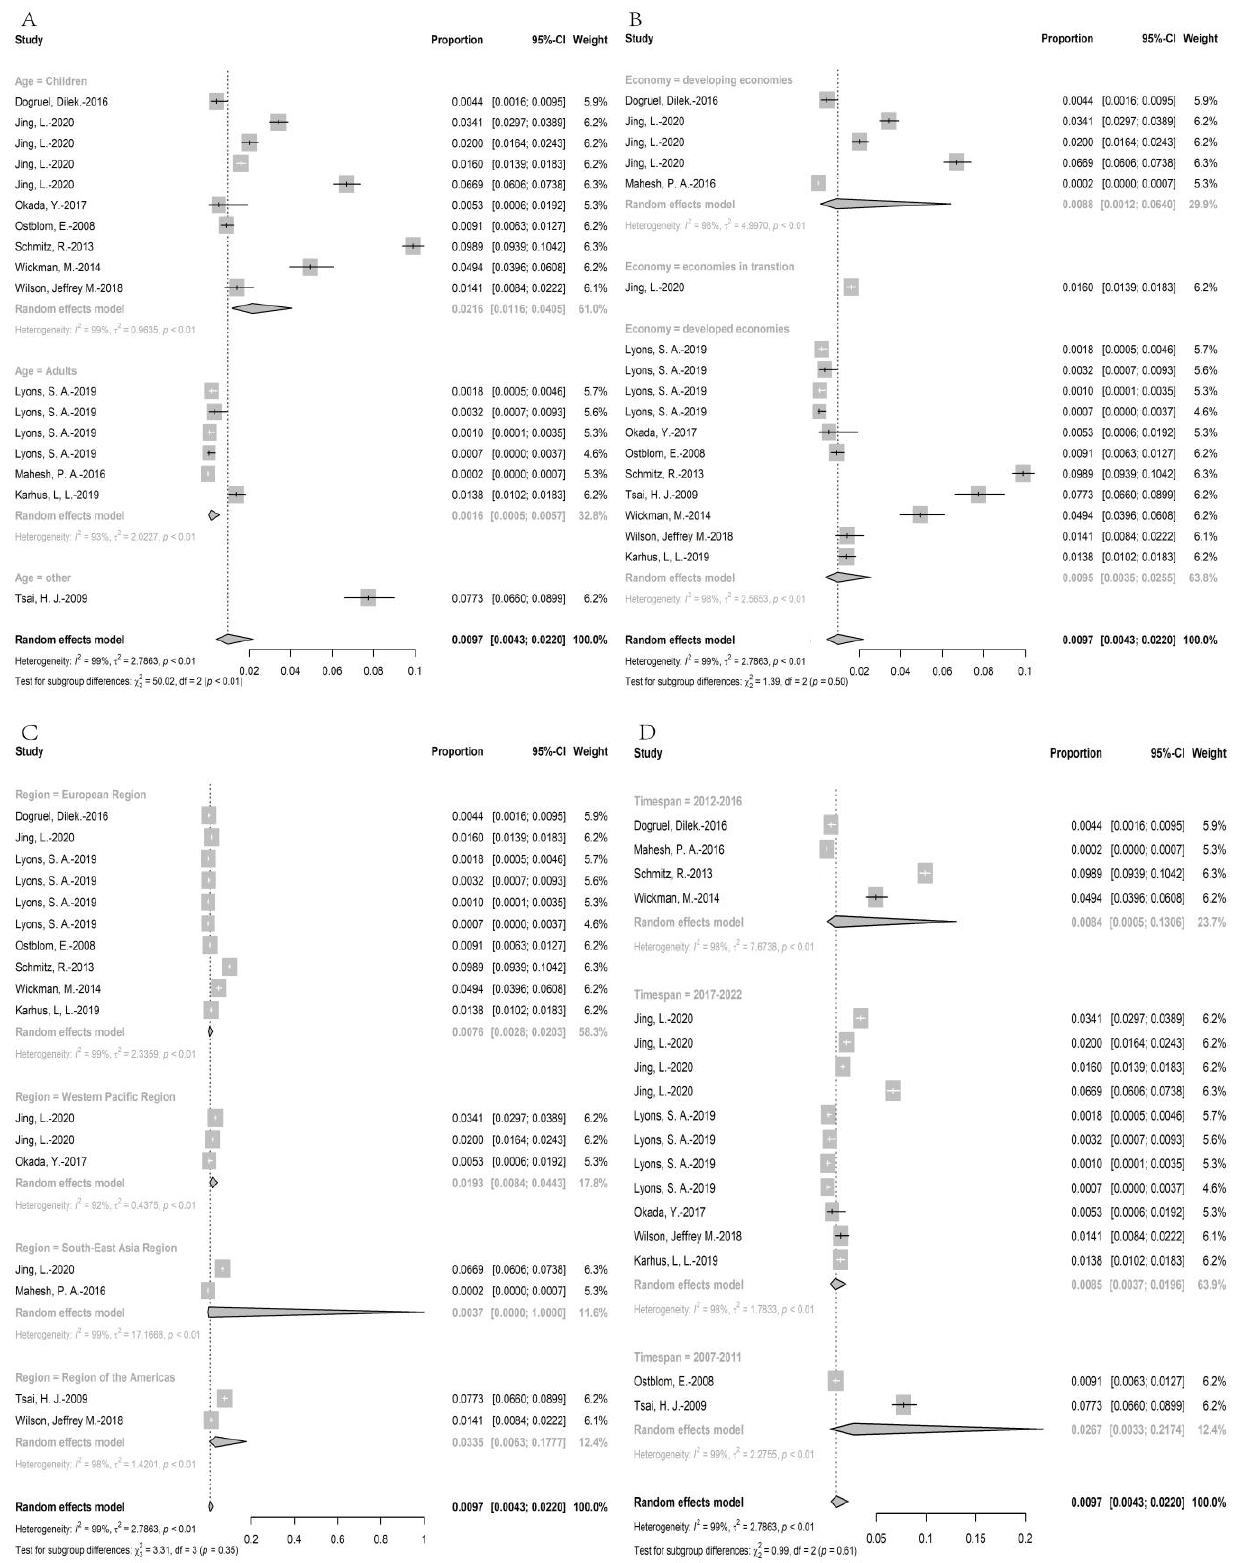
Figure 5. The prevalence of wheat allergy for sIgE positive; ( A ): the subgroup analysis for age; ( B ): the subgroup analysis for economy; ( C ): the subgroup analysis for region, ( D ): the subgroup analysis for timespan [25,38–40,45,48,53,58,64,65,69].